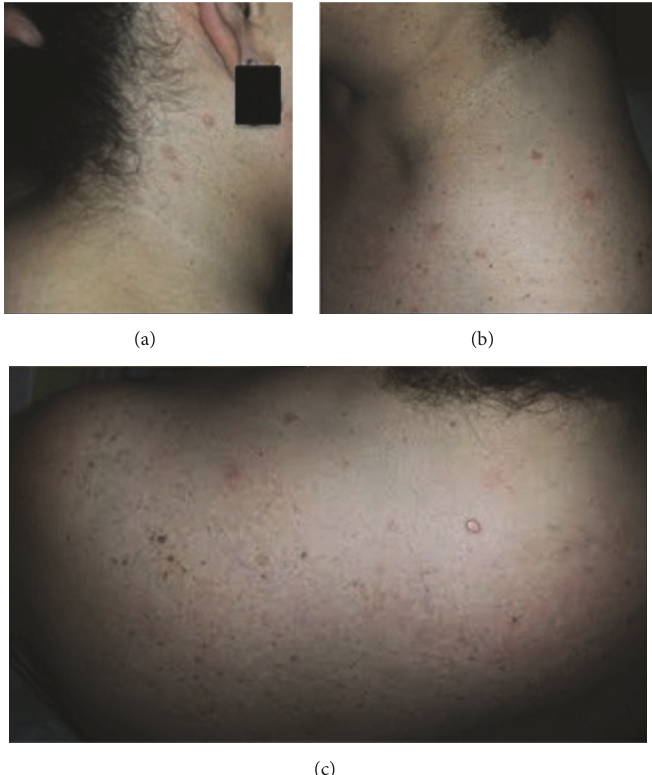
Figure 1: The patient on initial presentation. Tan papules were noted on (a) the right neck, (b) the left neck, and (c) the superior back and